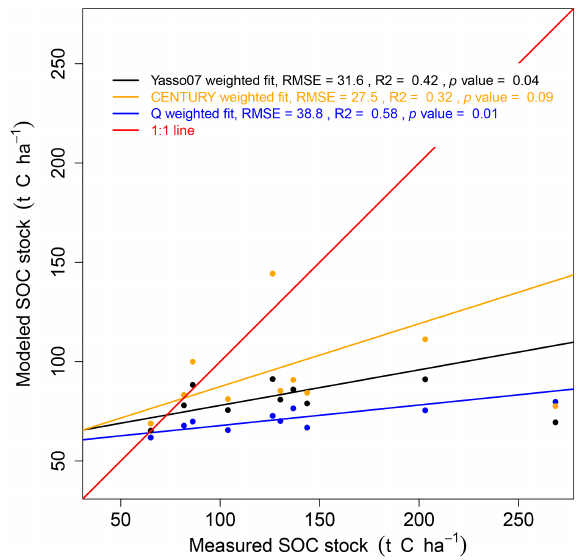
Figure 4. Scatter plot between mean measured and mean mod- eled soil organic carbon stocks (tCha − 1 ) for 10 physicochemical groups for Yasso07, CENTURY and Q models. Data were fitted with weighted linear regression (lines). The number of samples in each group was used as weights for fitting and also as weights for the weighted mean of squared differences between the modeled and measured values (MSE, tCha − 1 ). The RMSE is the square root of MSE. The r 2 is the proportion of explained variance. The p value is the calculated probability that the fit is